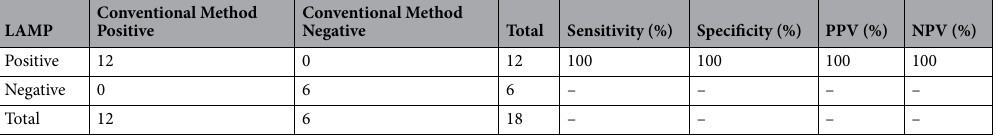
Table 2. Comparative analysis of conventional method and LAMP detection of ML.